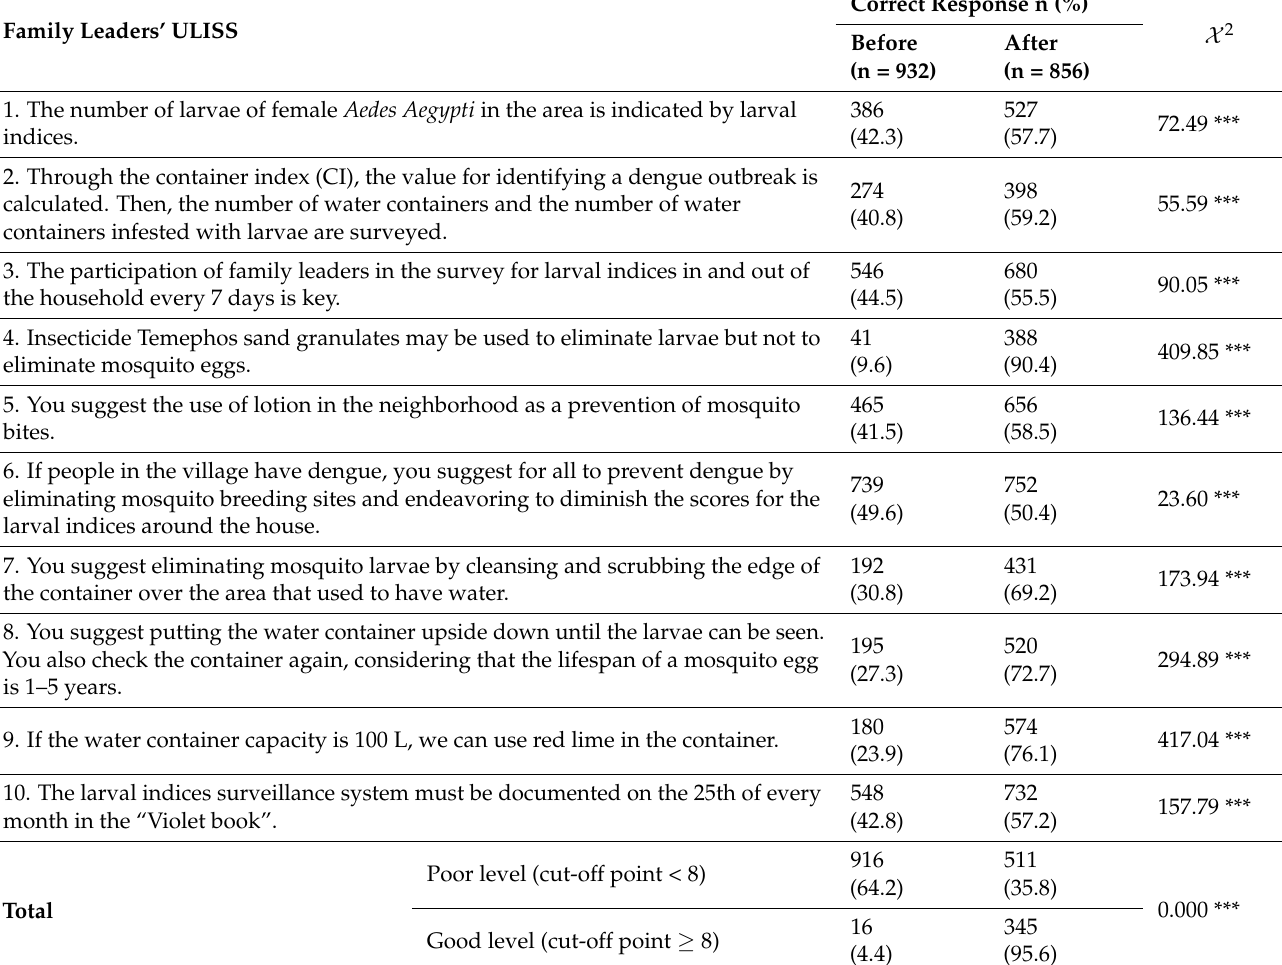
Table 7. Comparison of correct response rates regarding the ULISS for family leaders before and after implementation of the training programs.